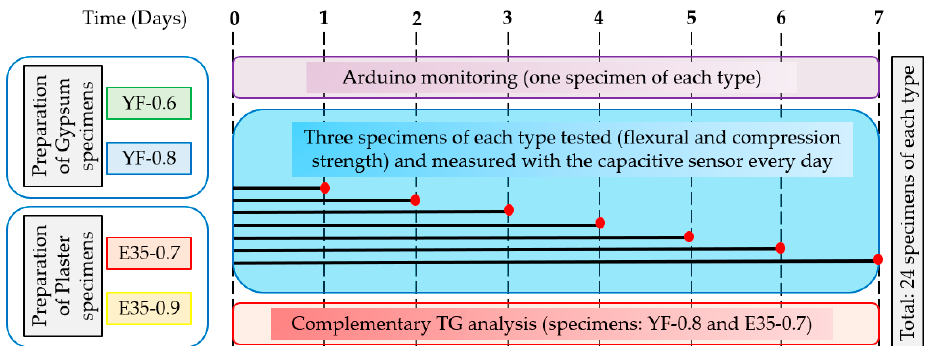
Figure 7. Experimental program and tests carried out.